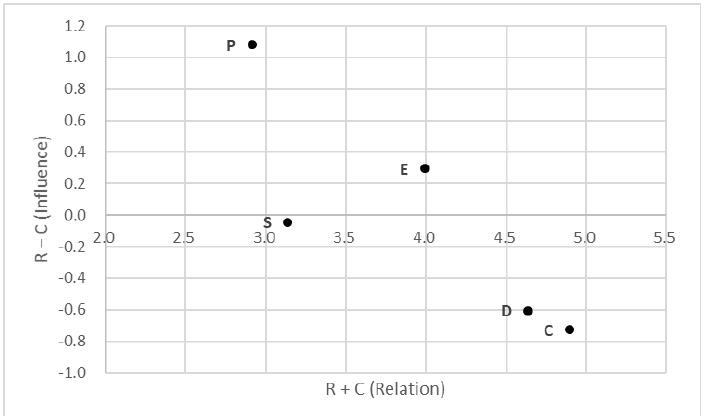
Figure 4. R − C influences for various R + C relations. Where P is policy and legal risks; E is economic downturn; S is stakeholder conflict; D is decision failures; C is capital chain rupture.